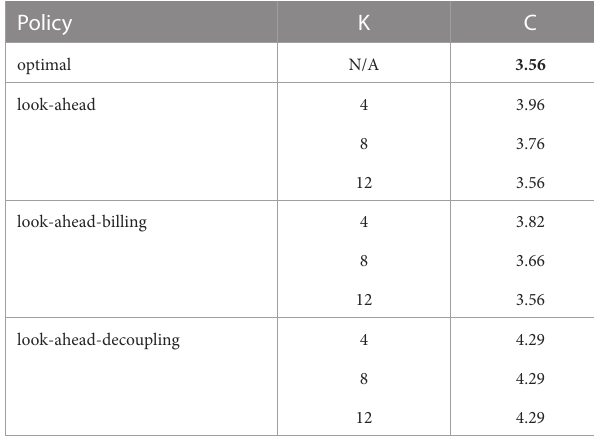
TABLE1 Size(infinancialterms)oftheelectricitybillofmember C bytesting thethreepolicieswithseveralpolicyhorizonsforthesimpleREC,compared withthe optimal policy(equivalenttothelook-aheadpolicywith K = T = 24 ). Theelectricitybillof PVB isnotshowninthistable;itsvalueis0forallpolicies